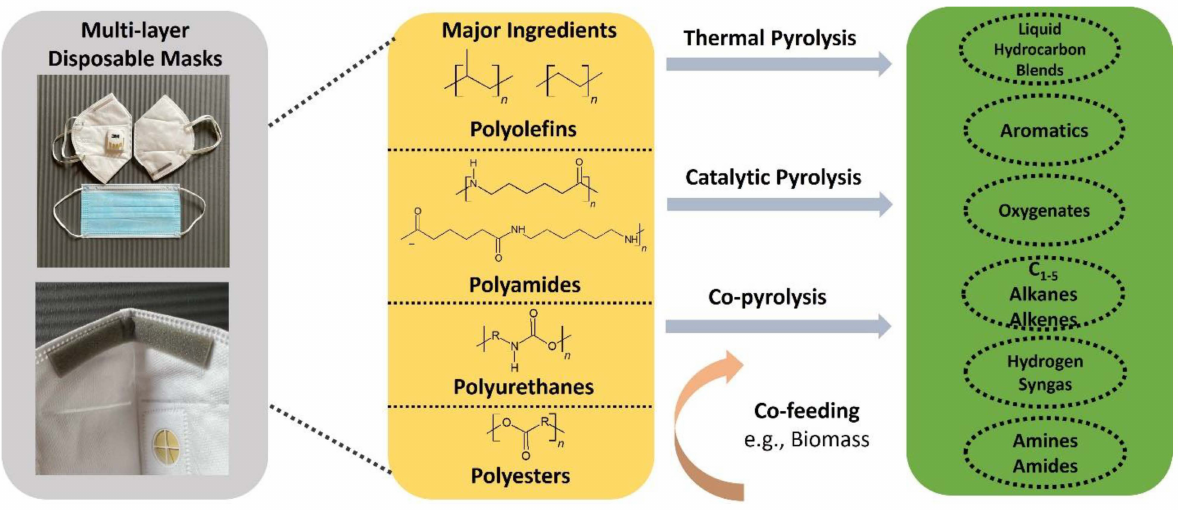
Figure 1. The direct and selective pyrolysis of polymer-made disposable masks (surgical masks and KN95 masks) to produce fuel-range chemicals with three different methods: thermal pyrolysis, catalytic pyrolysis, and co-pyrolysis. All the masks are assembled with multiple facial layers of polymeric materials, stretchable ear loops, and nose